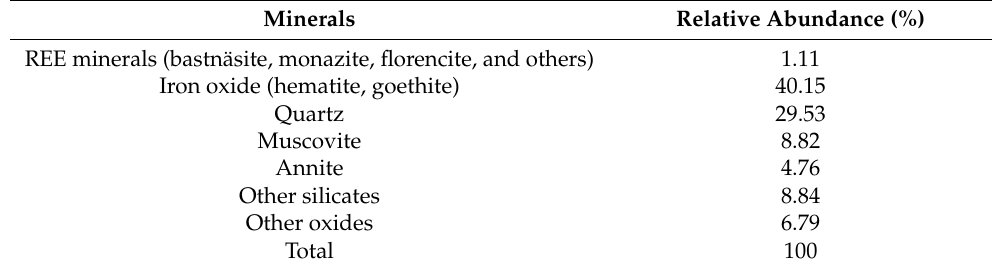
Table 2. Mineral mass composition in the raw tailings sample obtained via QEMSCAN analysis. Minerals Relative Abundance (%) REE minerals (bastnäsite, monazite, florencite, and